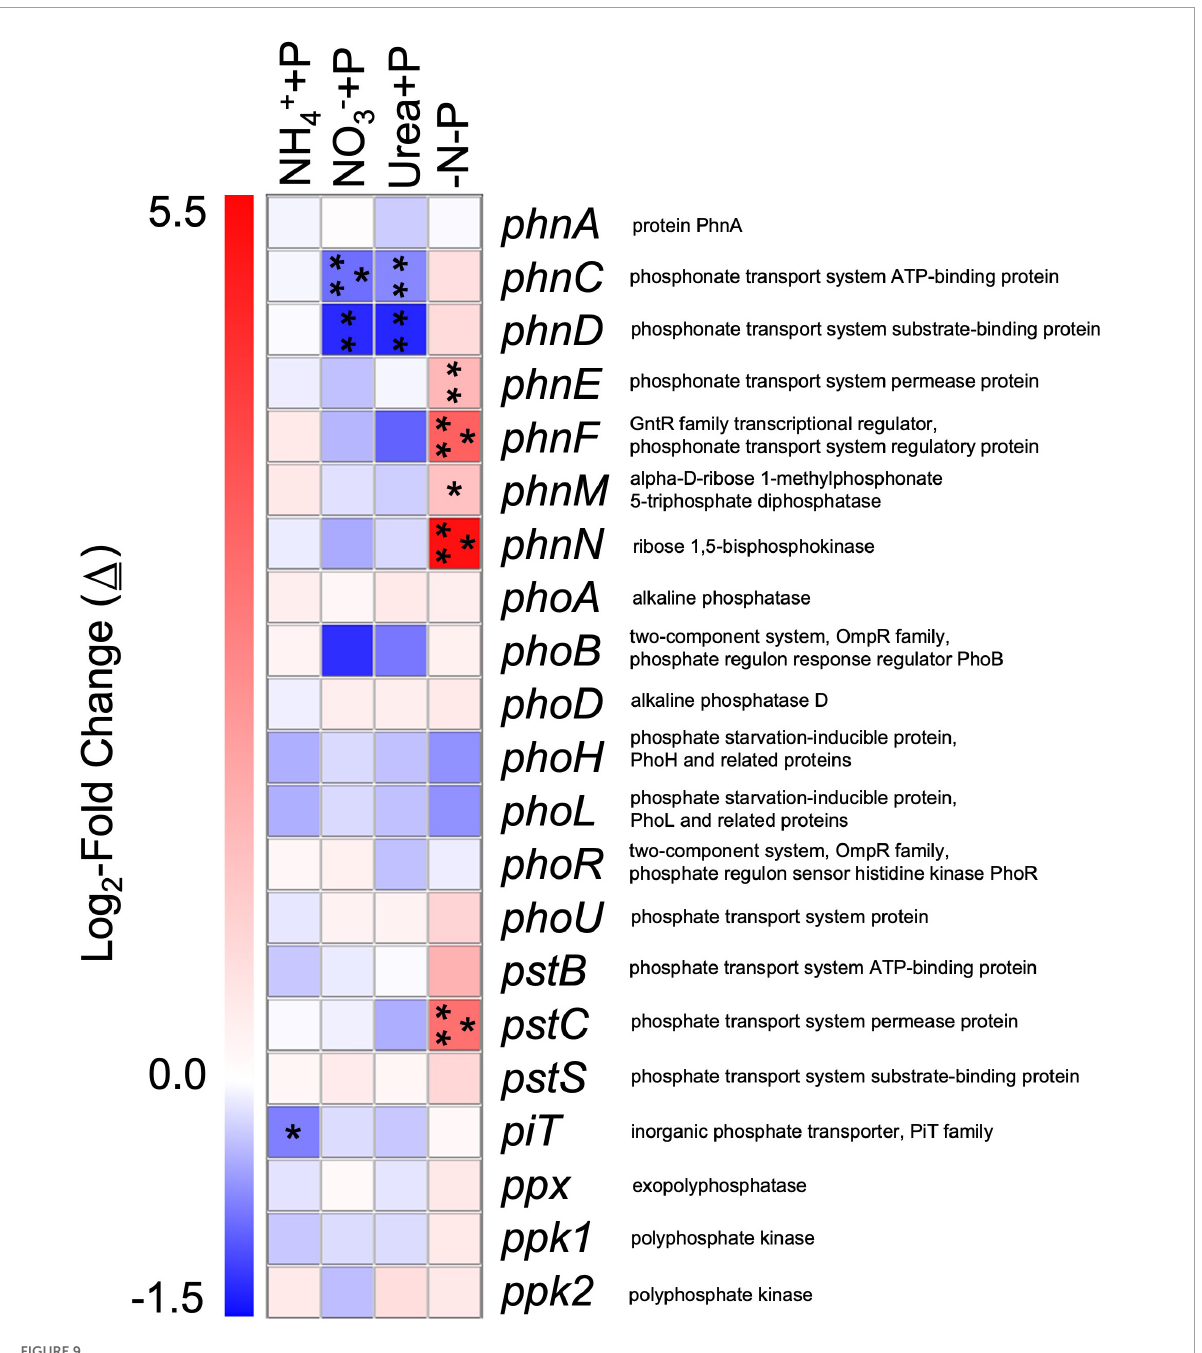
FIGURE9 Differential expression of gene transcripts associated with phosphorus acquisition and metabolism in experimental groups relative to the control/ − N + P. Heatmap representing log 2 -fold changes ( (cid:49) ) in phosphorus metabolism/acquisition gene expression in experimental groups with their corresponding gene products. Red or blue coloration corresponds to up or down – regulation of genes relative to the control, respectively. Statistical analyses were determined on transcriptomic data post-Sleuth analysis using the Wald test ( qval < 0.05 = *, 0.01 = **, 0.001 =